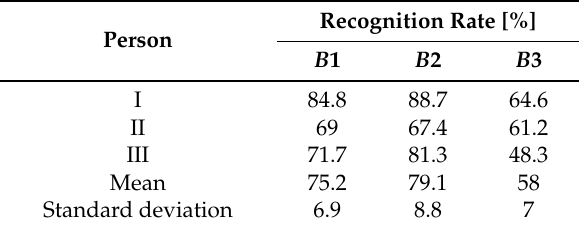
Table 4. Recognition rates of the method independent from the acronym dictionary using the best combination of features FS2 + ( E , C , L , S ) with T as the training set and A as the testing